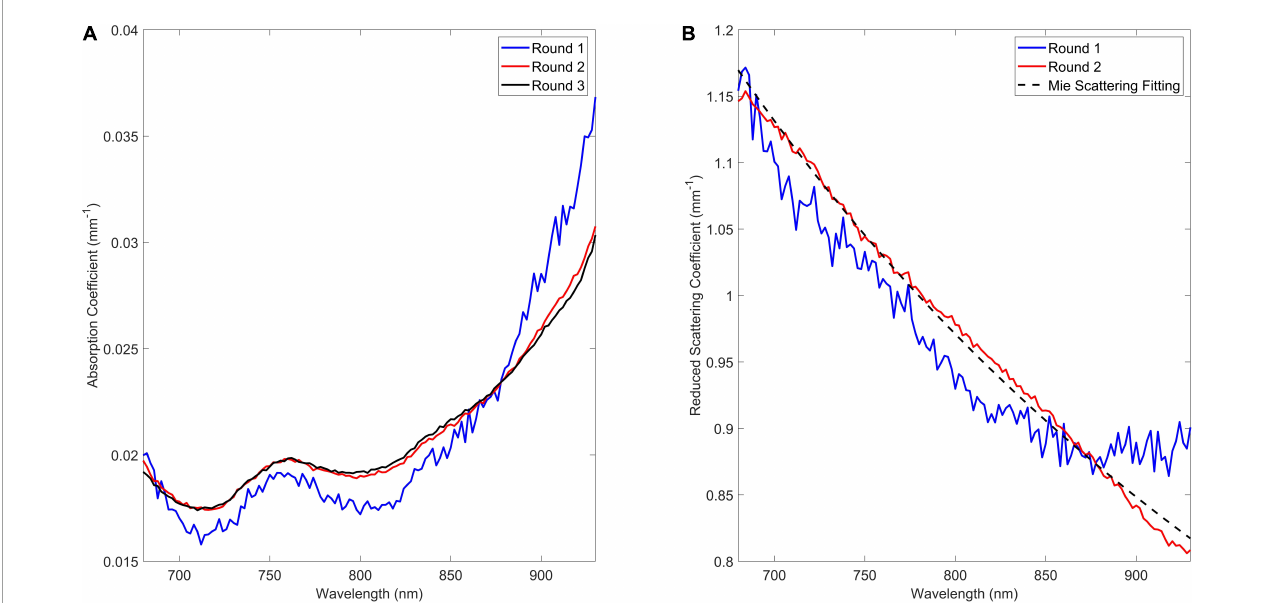
FIGURE2 Wavelength-dependent absorption (A) and reduced scattering (B) coefficient obtained following each round of fitting the 2 cm distance data assuming a homogenous